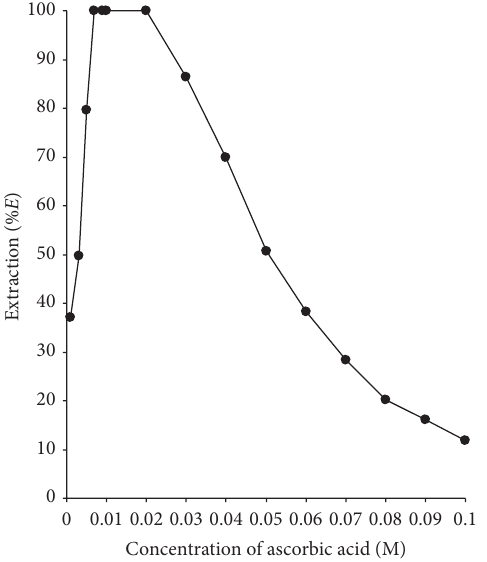
Figure 2: Extraction of platinum(IV) (150 𝜇 g) with 0.1M n- octylaniline at pH 0.50 as a function of weak acid